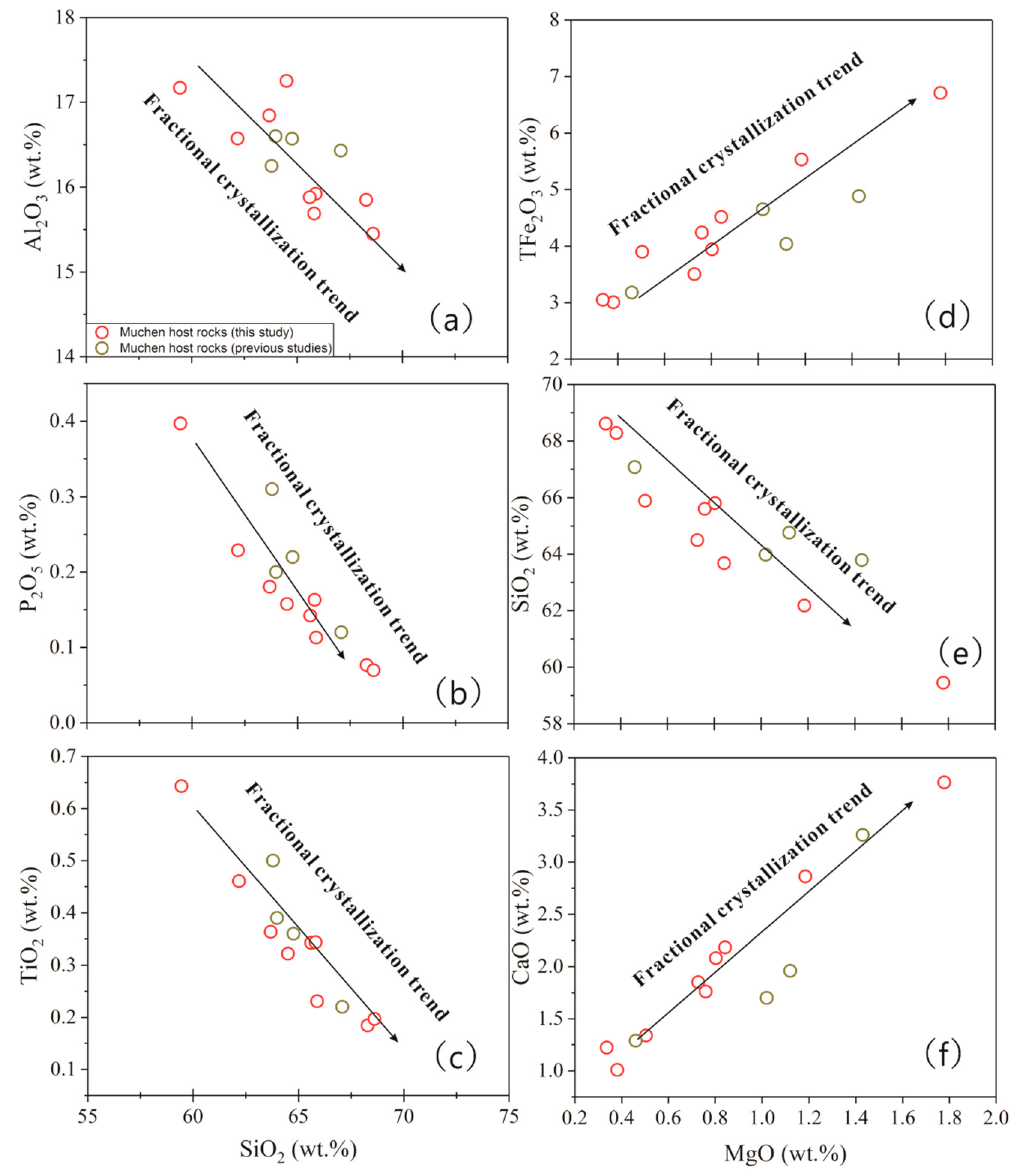
Figure 16. Bivariate plots of the Muchen alkaline rocks. Previous data of Muchen rocks are from [30]. The black arrow in figure ( a – f ) represents the fractional crystallization trend of Muchen magma.